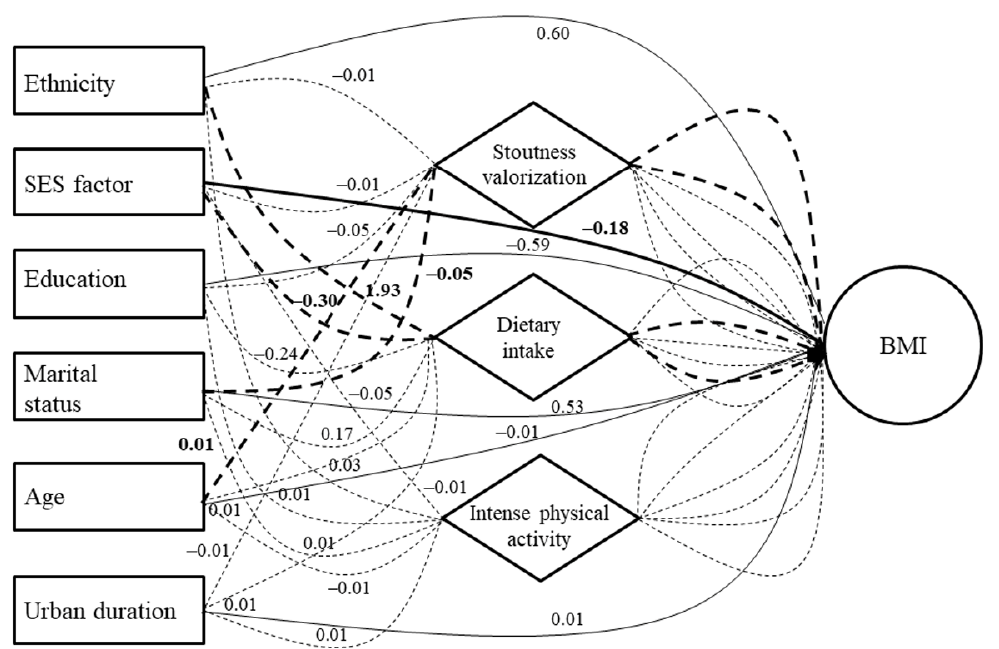
Figure 4. Results of structural equation modeling (SEM) showing associations between sociodemo- graphic/socioecological predictors and body mass index in men. Continuous lines are direct socio- demographic effects and dotted lines are indirect sociodemographic effects. Bold lines (continuous and dotted) represent statistically significant paths. Simple lines (continuous and dotted) represent statistically non-significant paths.